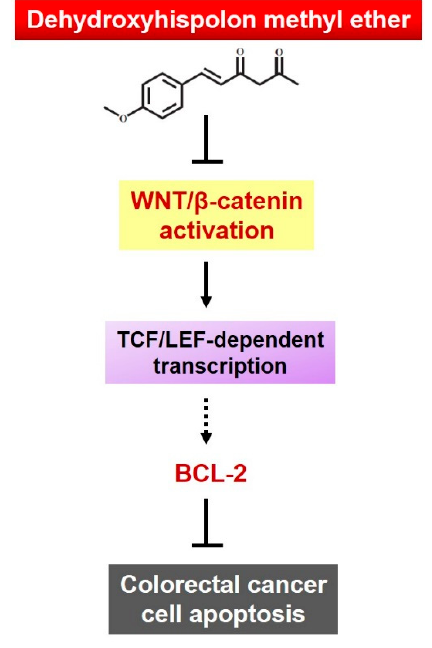
Figure 6. Schematic diagram depicting the anti-CRC mechanism of action of DHME elucidated in this study. In brief, DHME induces CRC cell apoptosis via the targeted inhibition of the pro-survival WNT / β -catenin–BCL-2 signaling axis. The chemical structure of DHME is adapted from Balaji et al. [18]. The dashed line denotes that our data implicated that the transcription of BCL-2 likely depends on the β -catenin–TCF / LEF transcription complex, but it still requires evidence to support the direct binding of TCF / LEF to the human BCL-2 promoter for driving BCL-2 transcription in the CRC cell lines used in this study.